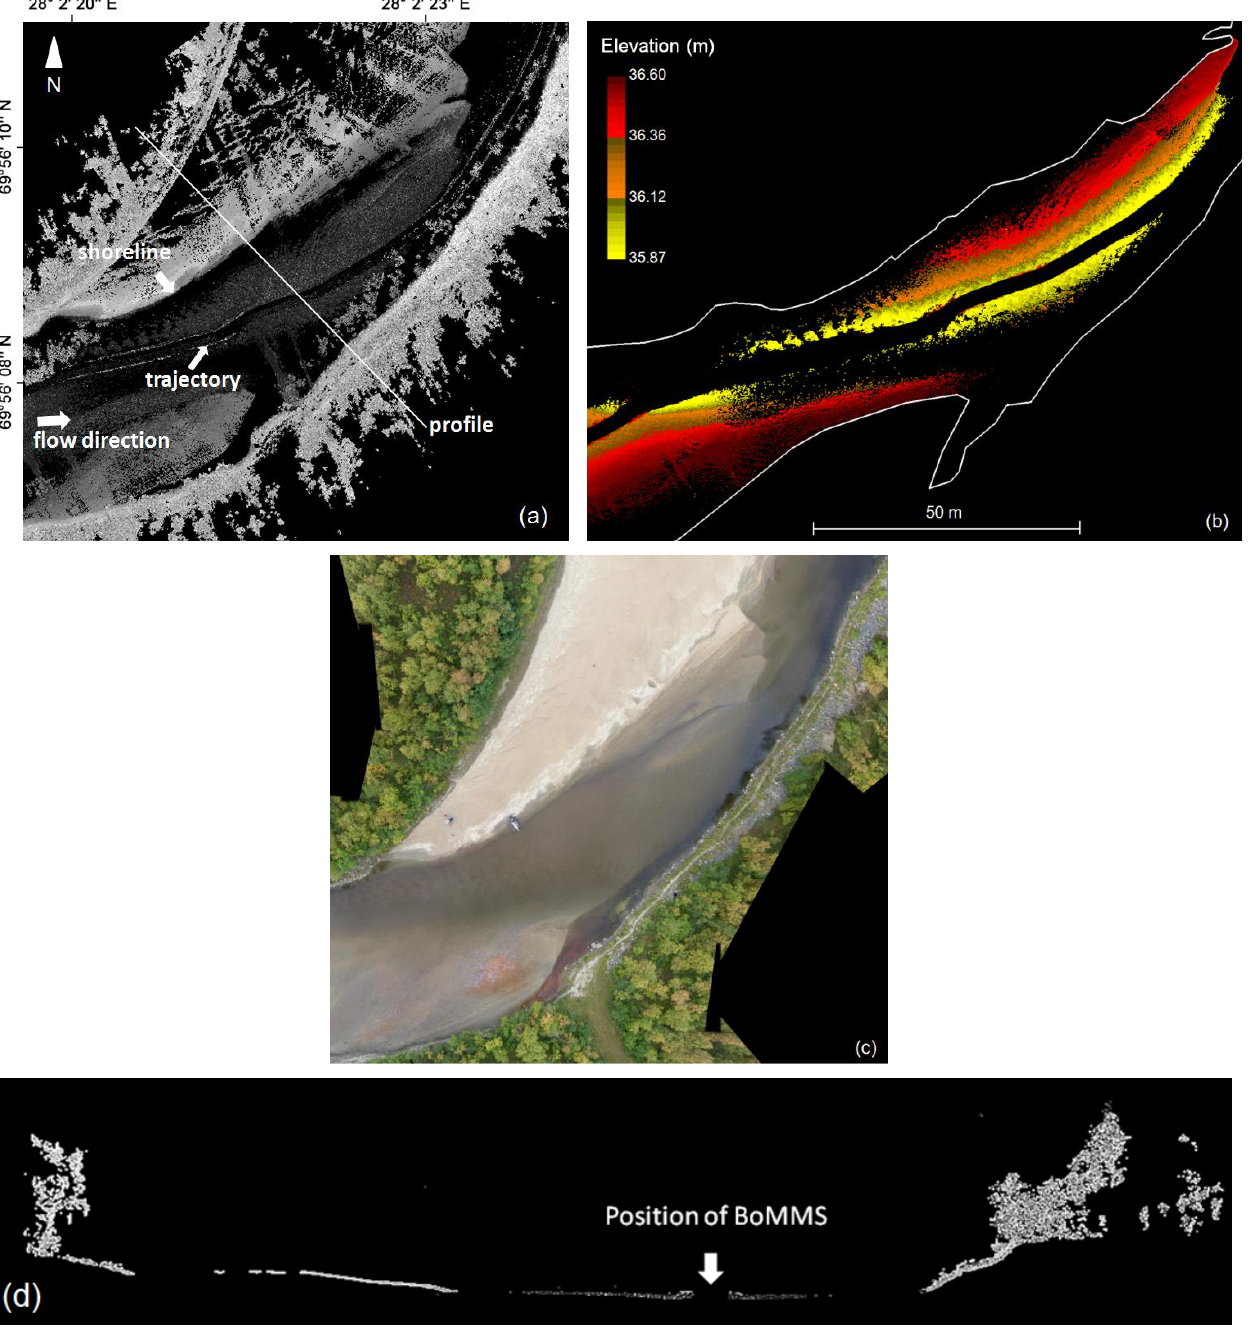
and near the water surface. The incidence angle at water surface varied approximately between 25° and 80° concerning bathymetry data. The smaller than 25° angles were occluded by boat. Figure 5. ( a ) Intensity image of the point cloud. The trajectory of the BoMMS is clearly visible as the occluded area in the middle of the river. The intensity value clearly changes at the border of the land and water areas; ( b ) The elevation coloured bathymetry points from the same area and digitized shoreline; ( c ) UAV mosaic; ( d ) Cross-sectional profile of the channel and point bar (location of the profile is marked on ( a